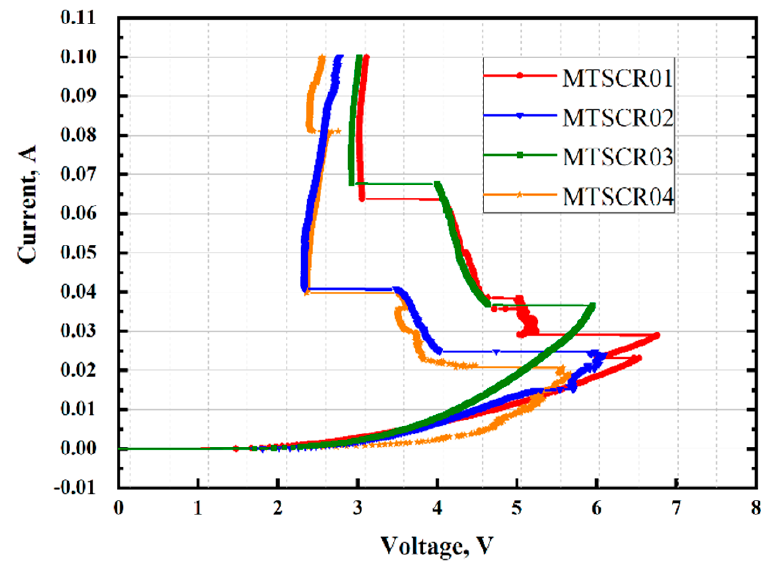
◦ C. Figure 5. DC sweep of MTSCR1, MTSCR2, MTSCR3, and MTSCR4 at 150 °C. Figure 5. DC sweep of MTSCR1, MTSCR2, MTSCR3, and MTSCR4 at 150 The MTSCR devices with different width of ENMOSs W N are evaluated by TLP measurement as shown in Figure 6. It is clearly observed that the I t2 of the devices has no reduction with the W N decreased. This is because the ENMOSs-string of the MTSCR dominates the gate voltage bias of the INMOS. Since the INMOS turned on, the inherent SCR of the MTSCR will be triggered by the INMOS current assistance, and then most of the ESD current will shunt to the inherent SCR path.